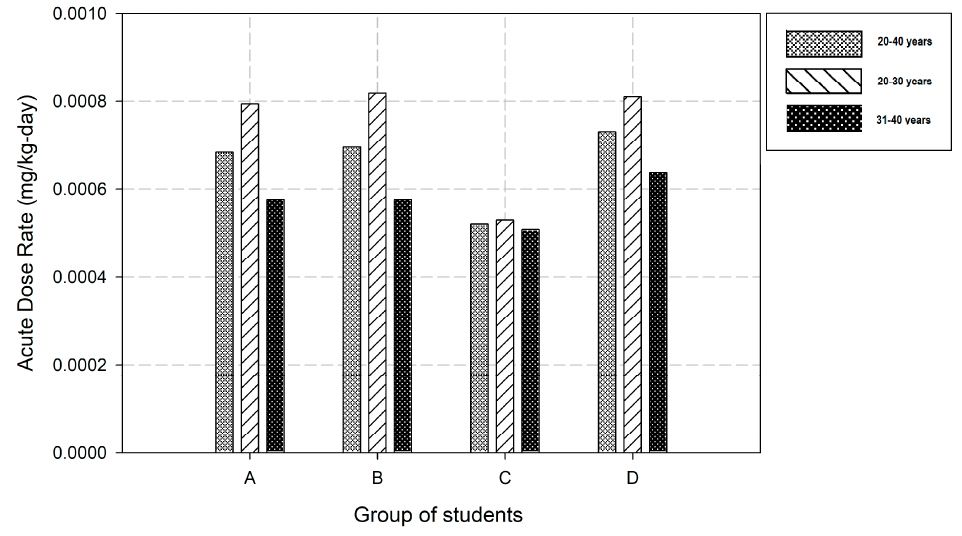
Figure 3. Acute dose rates estimated for the groups of students (A, B, D—mixed groups; C—only females); columns order: 20–40 years; 20–30 years; 31–40 years.